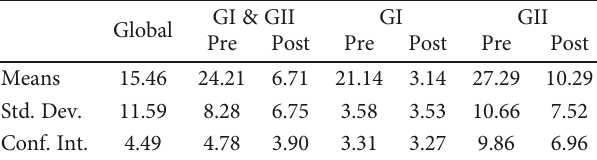
Table 3: Statistical description of VHI test results.